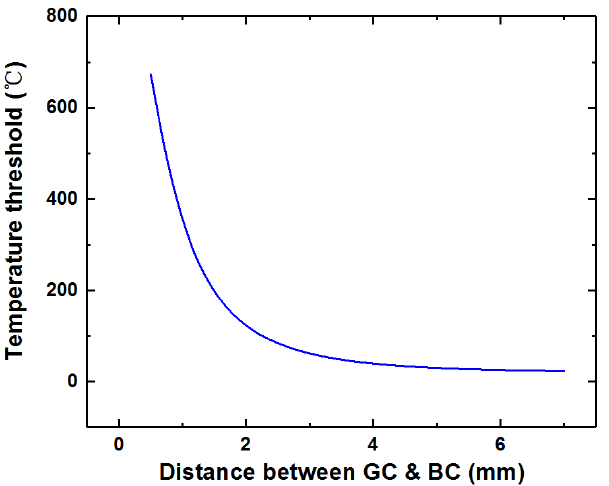
Figure 4. The relationship between the temperature threshold and the distance between the two stages of the energy